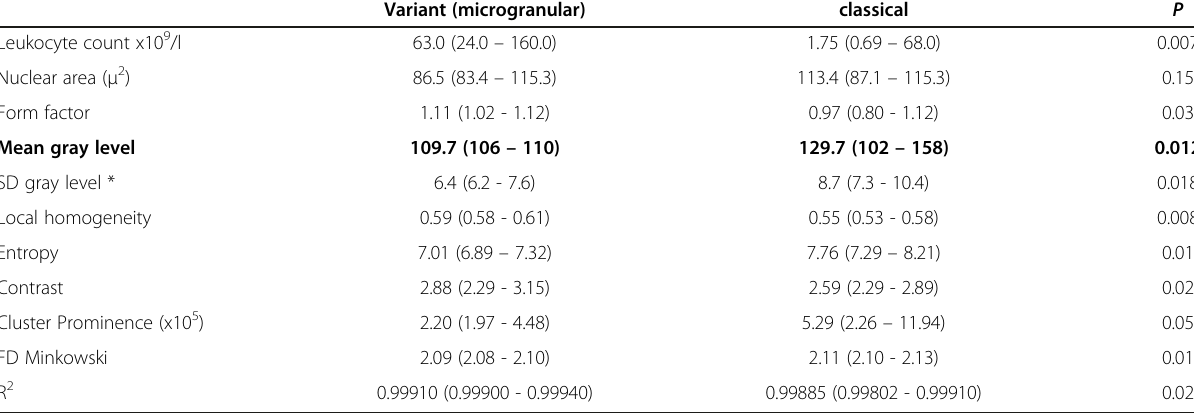
Table 4 Peripheral leukocyte counts and morphometric features of patients with APL according to the morphological type (median and range) Variant (microgranular)